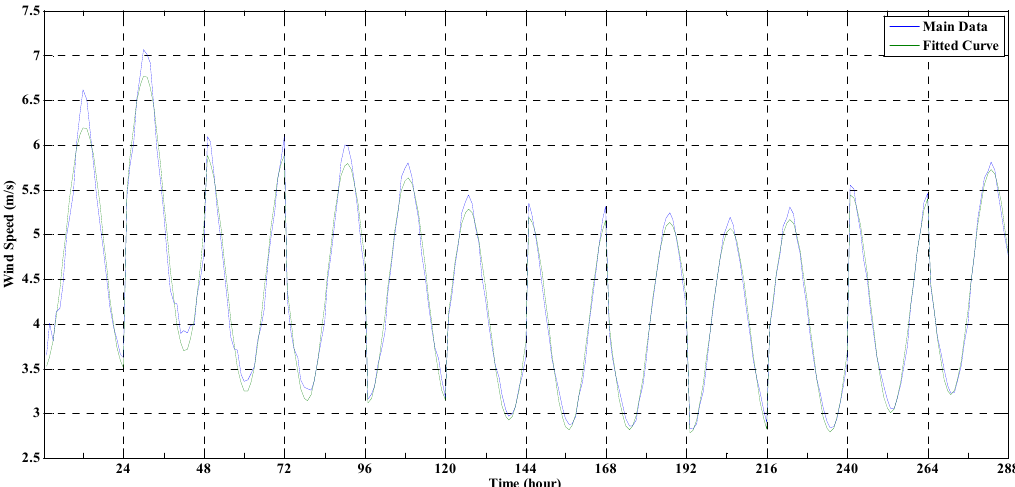
Figure 2. Monthly average diurnal wind speed patterns utilized.